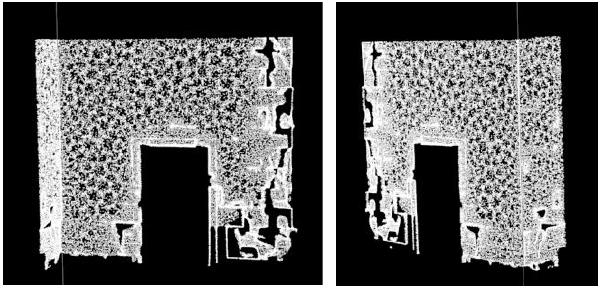
Figure 7. Displaying planes and their edge from two different views